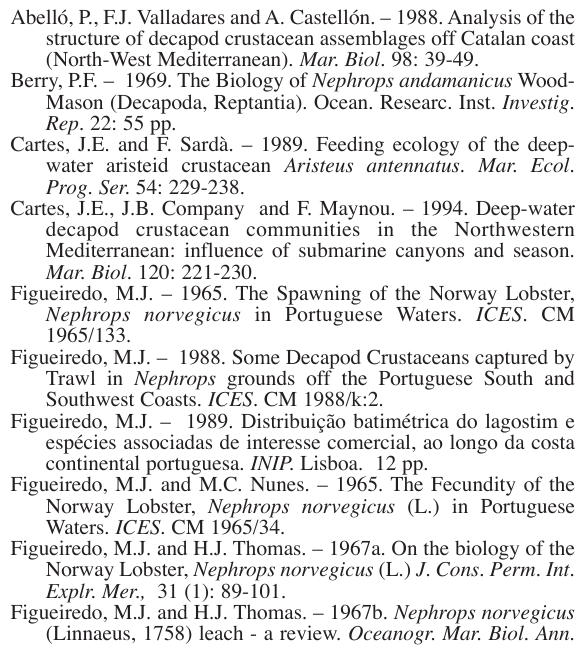
DIET OF N. NORVEGICUS IN THE MEDITERRANEAN AND ADJACENT ATLANTIC